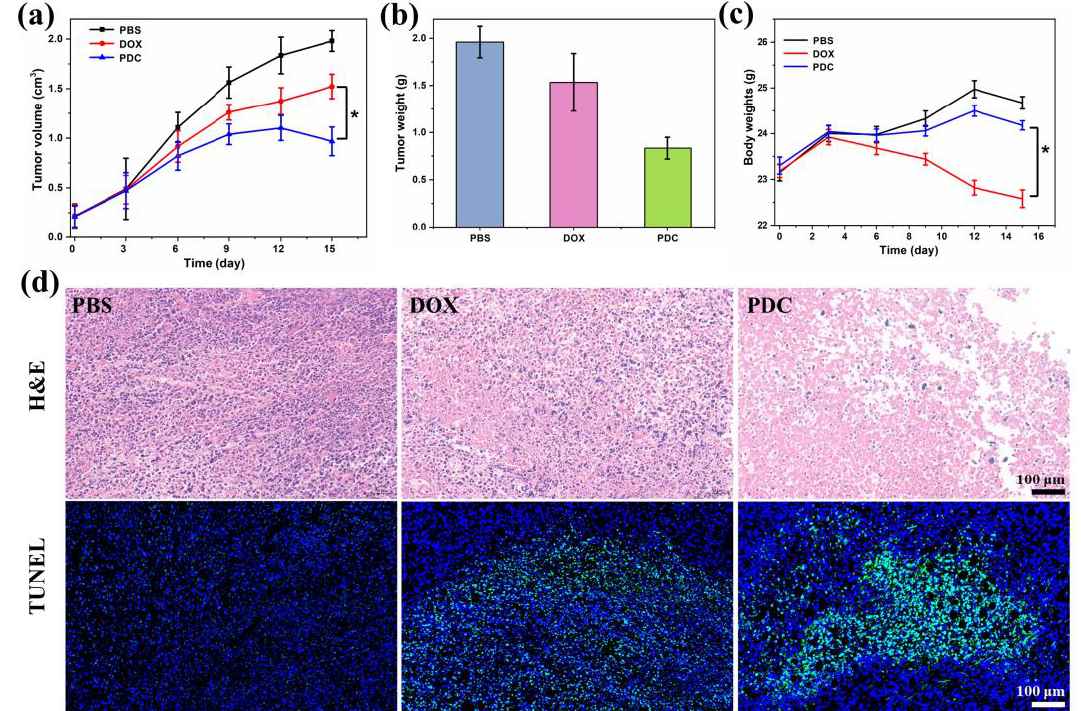
Figure 5. In vivo anti-tumor effect of the PDC. ( a ) Tumor growth curves after the treatment of saline, free DOX, and the PDC. ( b ) Tumor weight after intravenous administration. ( c ) Body weight change curves. ( d ) Analysis of the tumor slices with H&E and TUNEL staining in different therapeutics. Errors were determined with one-way analysis of variance (ANOVA). * p < 0.05 indicate statistical significance.